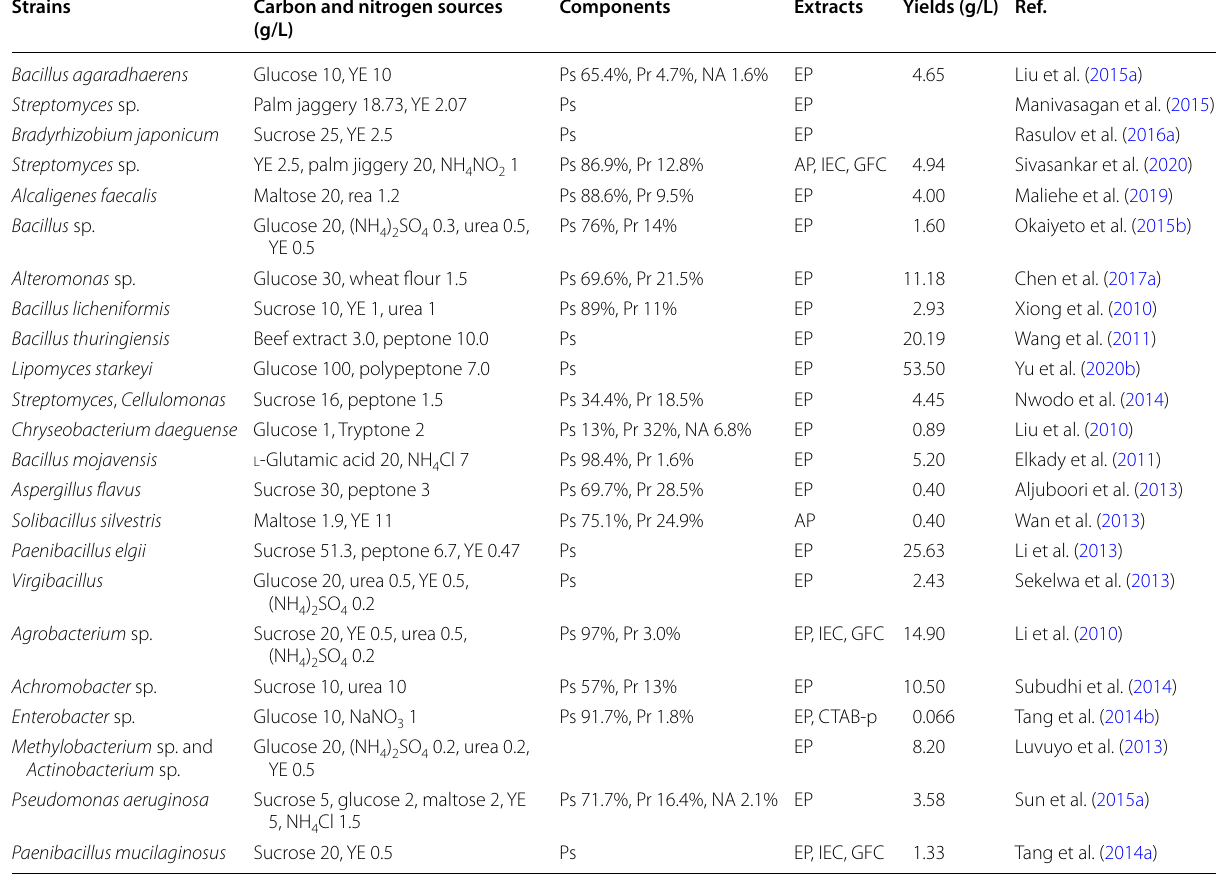
YE yeast extract, Ps polysaccharide, Pr protein, NA nucleic acid, EP ethanol precipitate, AP acetone precipitate, IEC Ion exchange chromatography, GFC Gel filtration chromatography, CTAB-p cetyltrimethyl ammonium bromide precipitate